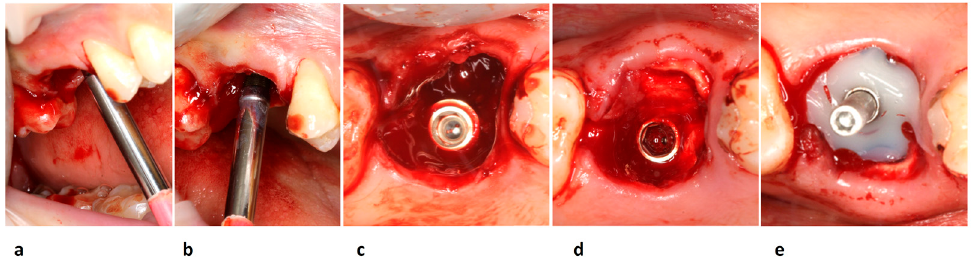
Figure 2. Dental implant placement steps. Implant bed preparation and control of implant direction in the mesial ( a ), and lateral view ( b ); occlusal view of placed dental implant ( c ); view of re-absorbable gelatin sponge around implant within the bone defect ( d ); screwed PEEK core healing abutment covered with moldable composite resin ( e ).